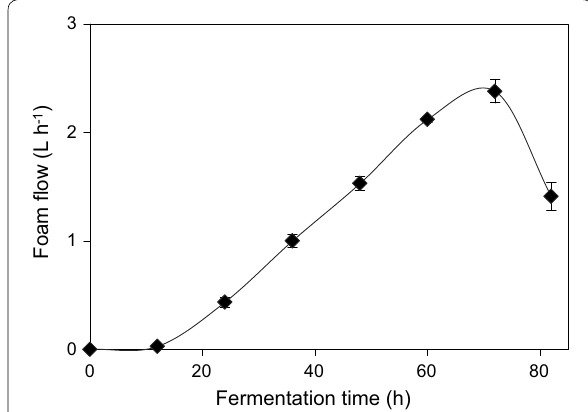
Fig. 5 Volumetric flow of the foam during the integrated fermentations. Foam volume and bacterial and rhamnolipid concentrations were measured after 30 min long foam collapse in the collection tube at room